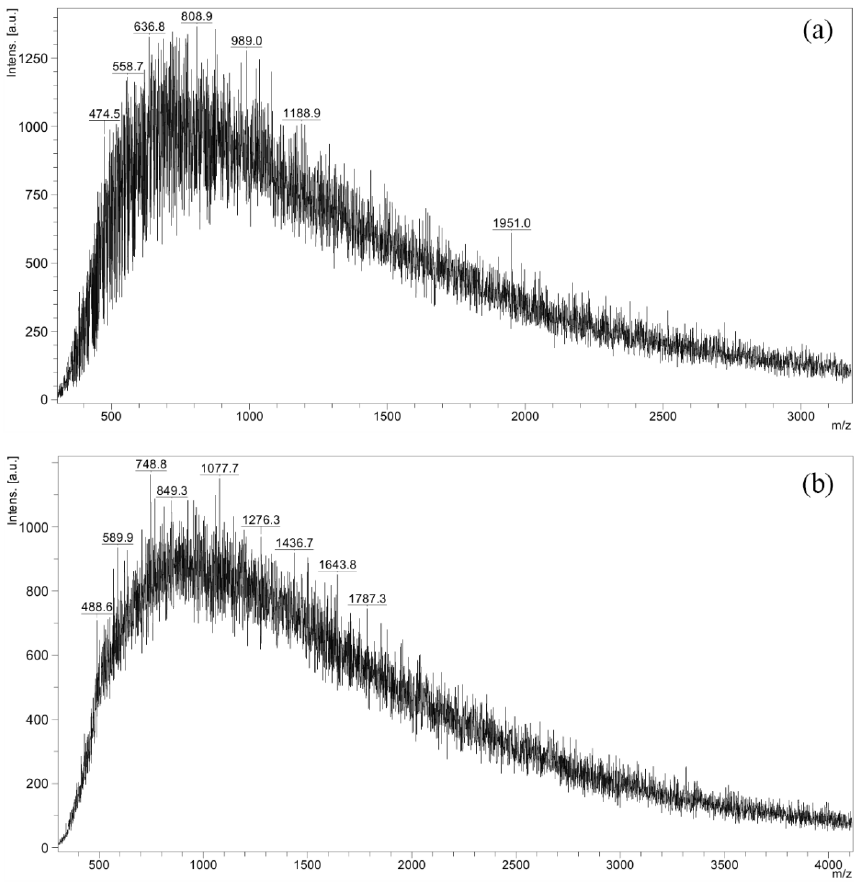
Figure 4. MALDI mass spectra of oil resins after catalytic exposure with the hydrogen donor (6 h): ( a ) R2; ( b ) R3.